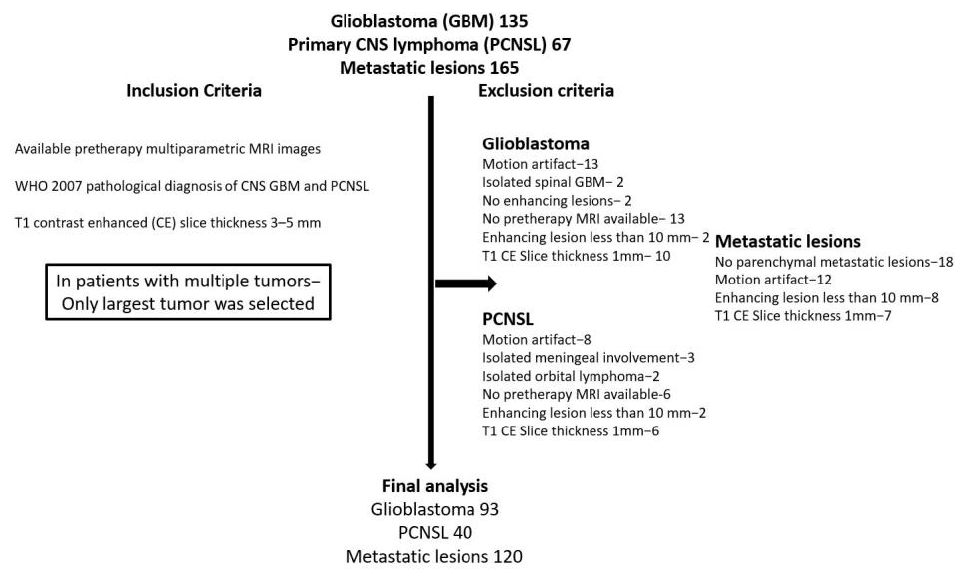
Figure 1. Patient selection criteria.